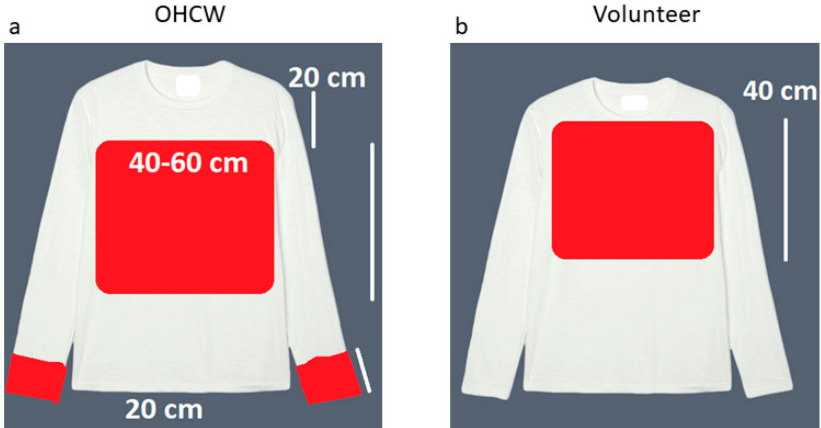
Figure 2. Long-sleeved fluid-resistant protective gown surfaces assessed for contamination ( a ) OHCW chest and wrists and ( b ) volunteer chest.